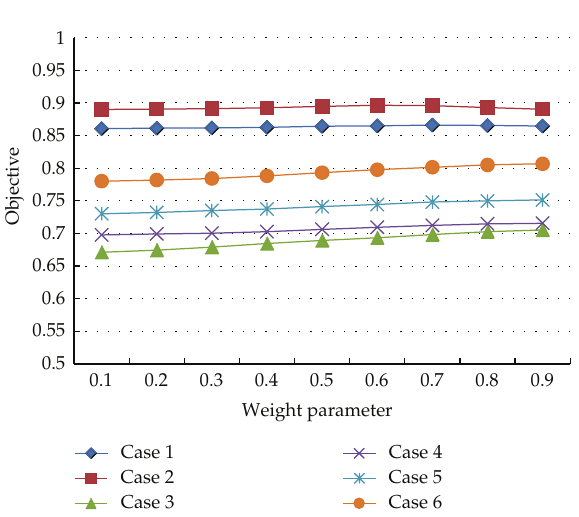
Figure 9: Optimal objectives with di ff erent